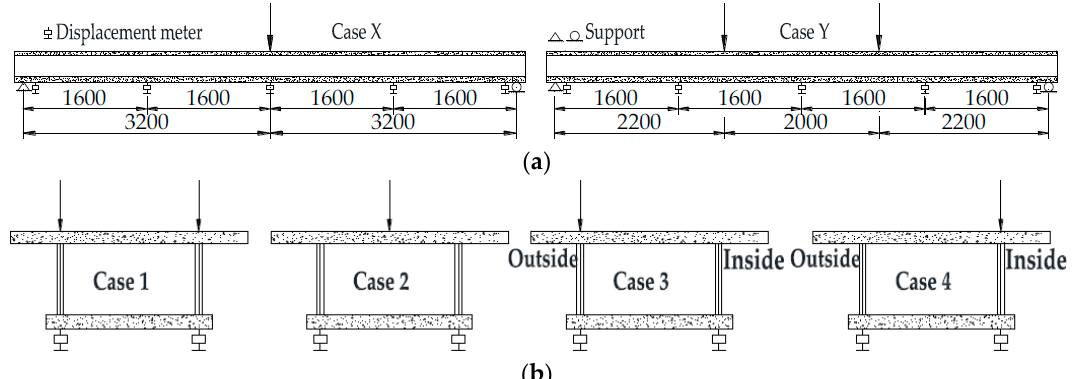
Figure 8. Schematic view of loading configurations: ( a ) Loading points applied in longitudinal direction; ( b ) Loading points applied in radial direction. Appl. Sci. 2019 , 9 , 1942